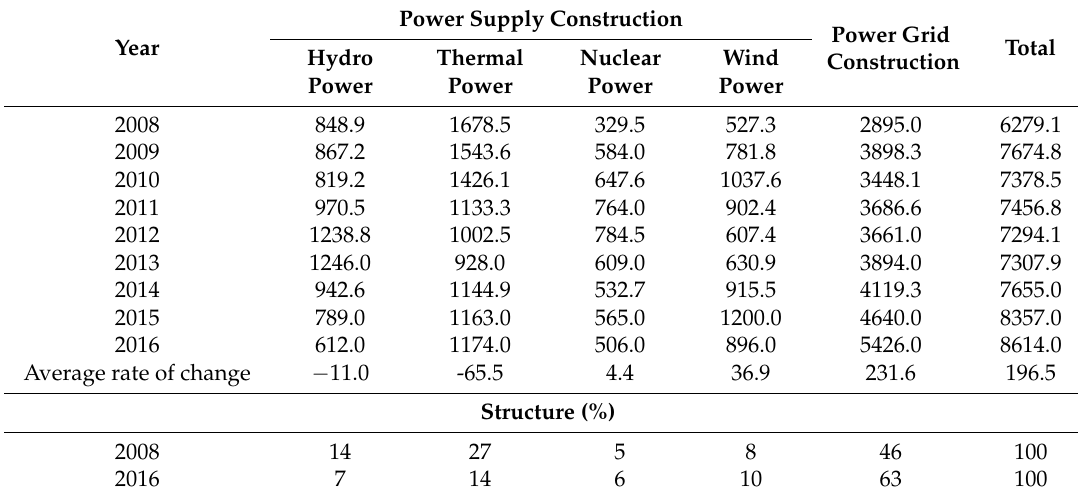
Table 3. Completed investments in power supply and grid infrastructure in China (100 million CNY),